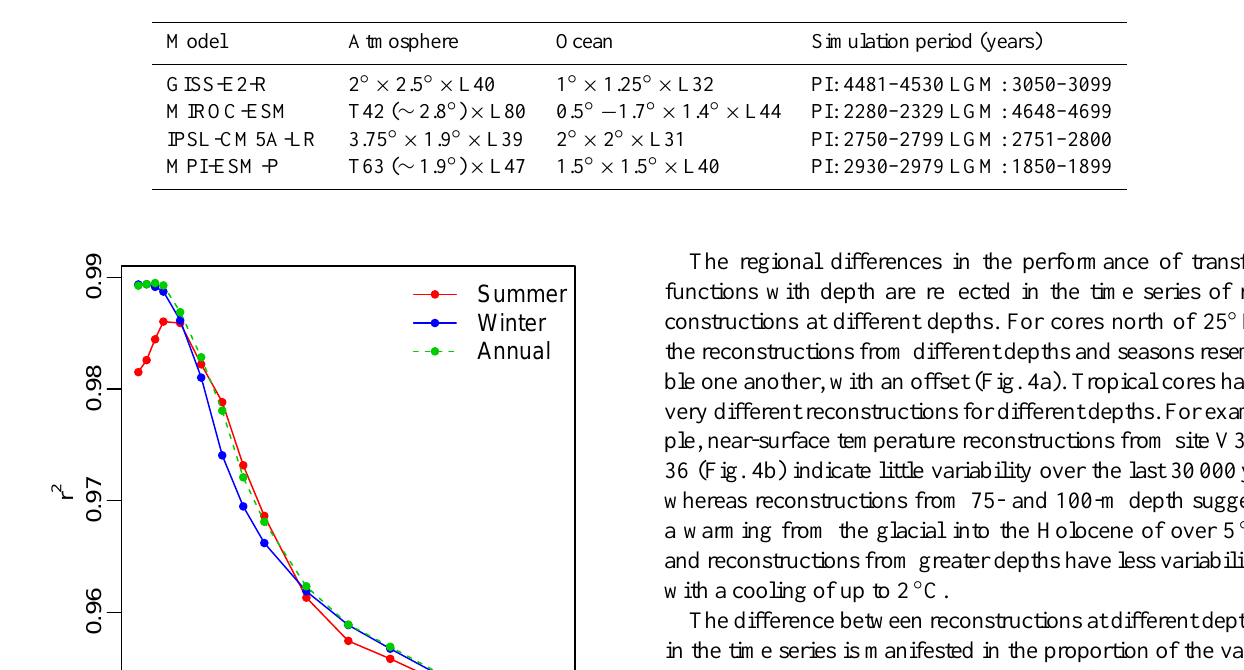
Table 2. CMIP5 coupled models and periods of the time slice simulations used in this analysis. The sponsoring institutions of the models are GISS-E2-R, NASA/GISS Goddard Institute for Space Studies, USA; MIROC-ESM, Center for Climate System Research (University of Tokyo), National Institute for Environmental Studies, and Frontier Research Center for Global Change (JAMSTEC), Japan; IPSL-CM5A-LR, Institut Pierre Simon Laplace, France; and MPI-ESM-P, Max Planck Institute for Meteorology, Germany.